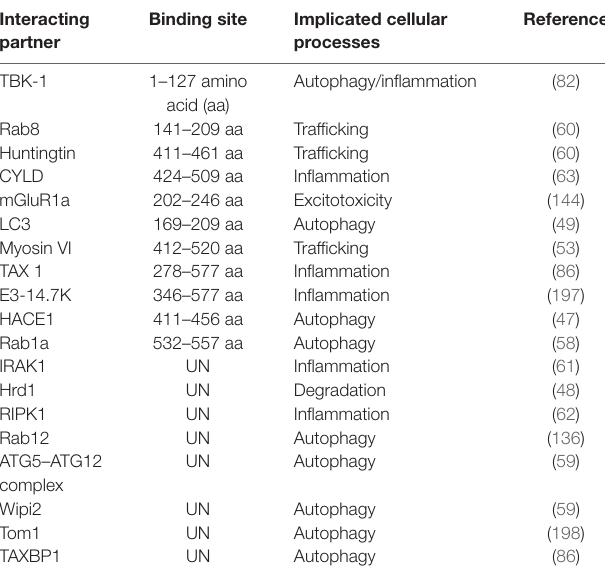
TAbLe 3 | Comprehensive list of putative optineurin-binding partners. interacting